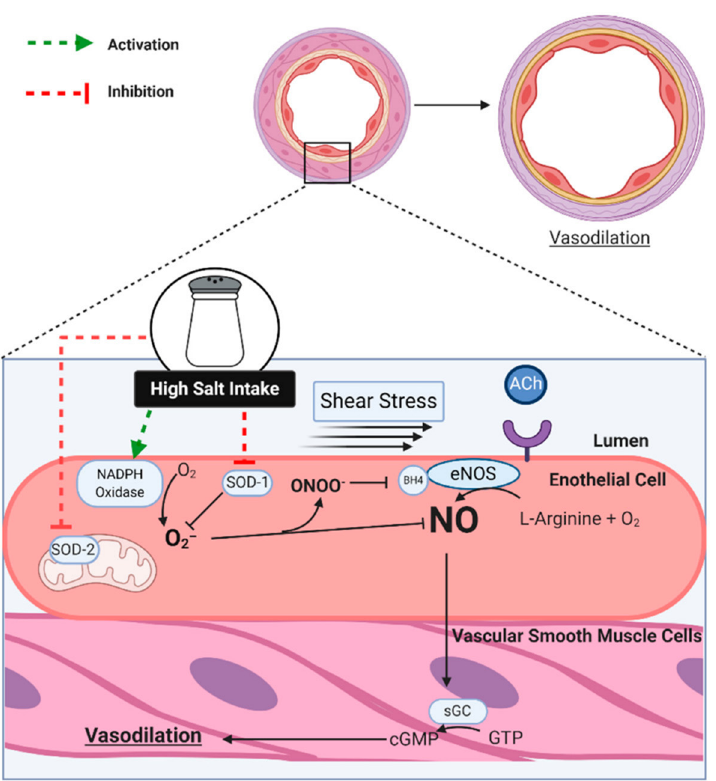
Figure 2. In response to various physiological and pharmacological stimuli, such as shear stress and acetylcholine (ACh), the endothelium produces nitric oxide (NO) via endothelial nitric oxide synthase (eNOS) that diffuses into the vascular smooth muscle cells, where it activates soluble guanylate cyclase (sGC), which then converts guanosine triphosphate (GTP) into cyclic guanosine monophosphate (cGMP), ultimately leading to vasodilation. Excess dietary sodium increases superoxide (O 2 − ) via activation of nicotinamide adenine dinucleotide phosphate (NADPH) oxidase, while also inhibiting cytosolic superoxide dismutase (SOD-1) and mitochondrial SOD (SOD-2). NO readily reacts with O 2 − , thus rendering it unable to diffuse into the VSM. The resulting peroxynitrite (ONOO − ) oxidizes tetrahydrobiopterin (BH4), which leads to uncoupling of eNOS, leading to further reductions in NO and increases in O 2 − (not shown).